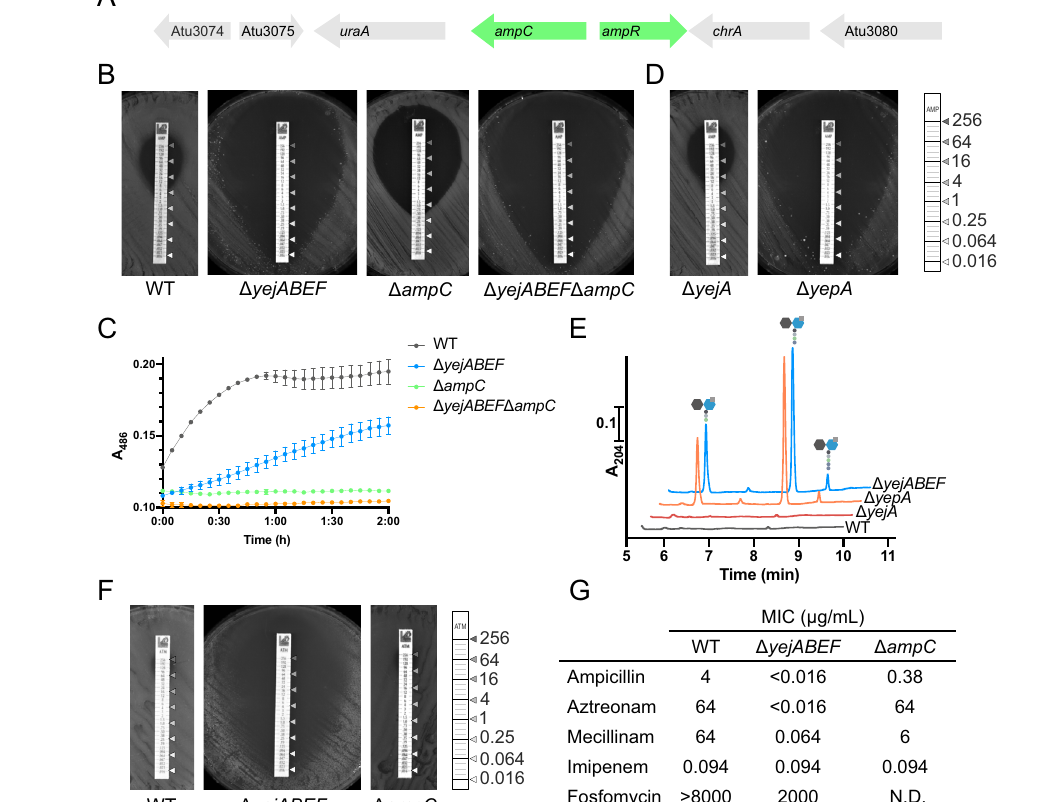
Fig. 3 | Δ yejABEF is hypersensitive to Ampicillin, in a manner only partly mean. Source data are provided as a Source Data fi le. D Comparison of Amp dependent on the β -lactamase AmpC. A Genomic context of the AmpC β - resistanceof A.tumefaciens Δ yejA and Δ yepA (Atu1774)strains. E Accumulationof lactamase in A. tumefaciens , showing proximity to canonical AmpR repressor. muropeptides in the supernatants of A. tumefaciens WT, Δ yepA , Δ yejA and Δ yejABEF strains,measuredbyUPLC. F ComparisonofAztreonamresistanceof A. B Comparison of Amp resistance of A. tumefaciens WT, Δ yejABEF , Δ ampC and Δ yejABEF Δ ampC strains by growth on LB plates with Ampicillin MIC test strips tumefaciens WT, Δ yejABEF and Δ ampC strains by growth on LB plates with ( μ g/mL). C Hydrolysis of nitroce fi n by lysates of A. tumefaciens WT, Δ yejABEF , Aztreonam MIC test strips. G Minimal inhibitory concentration(MIC) values of A. Δ ampC and Δ yejABEF Δ ampC strains, measured by following A tumefaciens WT, Δ yejABEF and Δ ampC to β -lactams Ampicillin, Aztreonam, 486 . n =3 biologi- cally independent experiments, error bars represent standard deviation from Mecillinam, Imipenem, and MurA-inhibitor